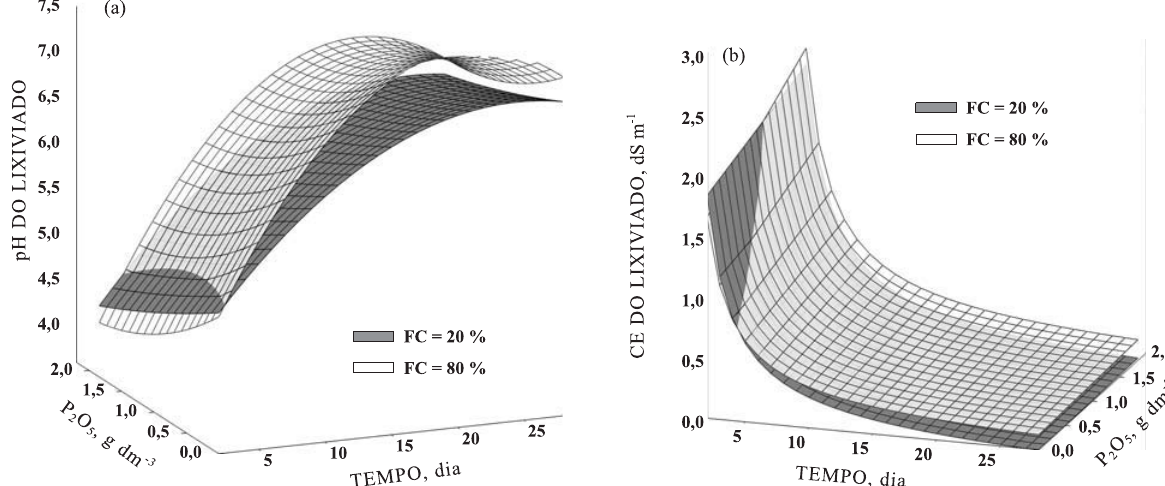
Figura 4. pH (a) e condutividade elétrica – CE (b) do lixiviado em função do tempo e da dose de P, para os substratos com 20 e 80 % de fibra de coco